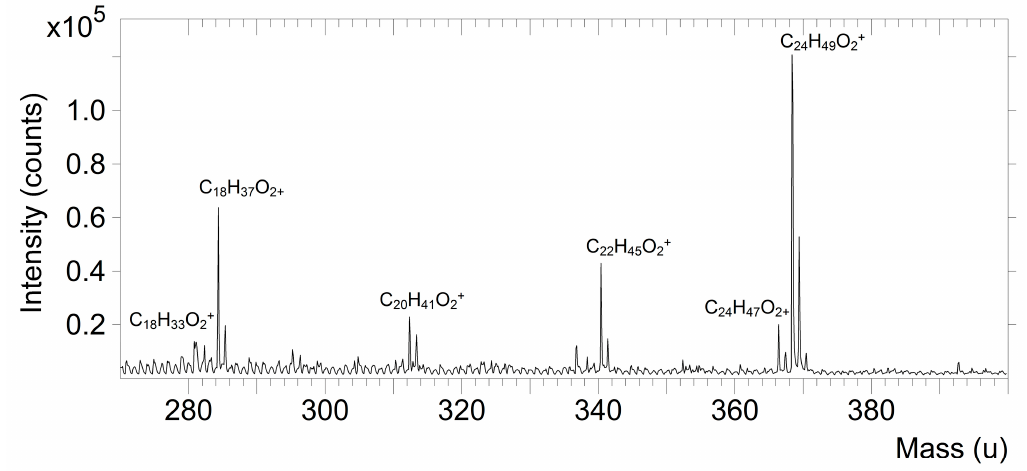
Figure 3. Part of positive ion mass spectra extracted from the gold area and showing the protonated fatty acids: linoleic (C 18 H 33 O 2+ , m/z 281), stearic (C 18 H 37 O 2+ , m/z 285), arachidic (C 20 H 41 O 2+ , m/z 314), behenic (C 22 H 45 O 2+ , m/z 341), nervonic (C 24 H 47 O 2+ , m/z 367), and lignoceric (C 24 H 49 O 2+ , m/z 369).